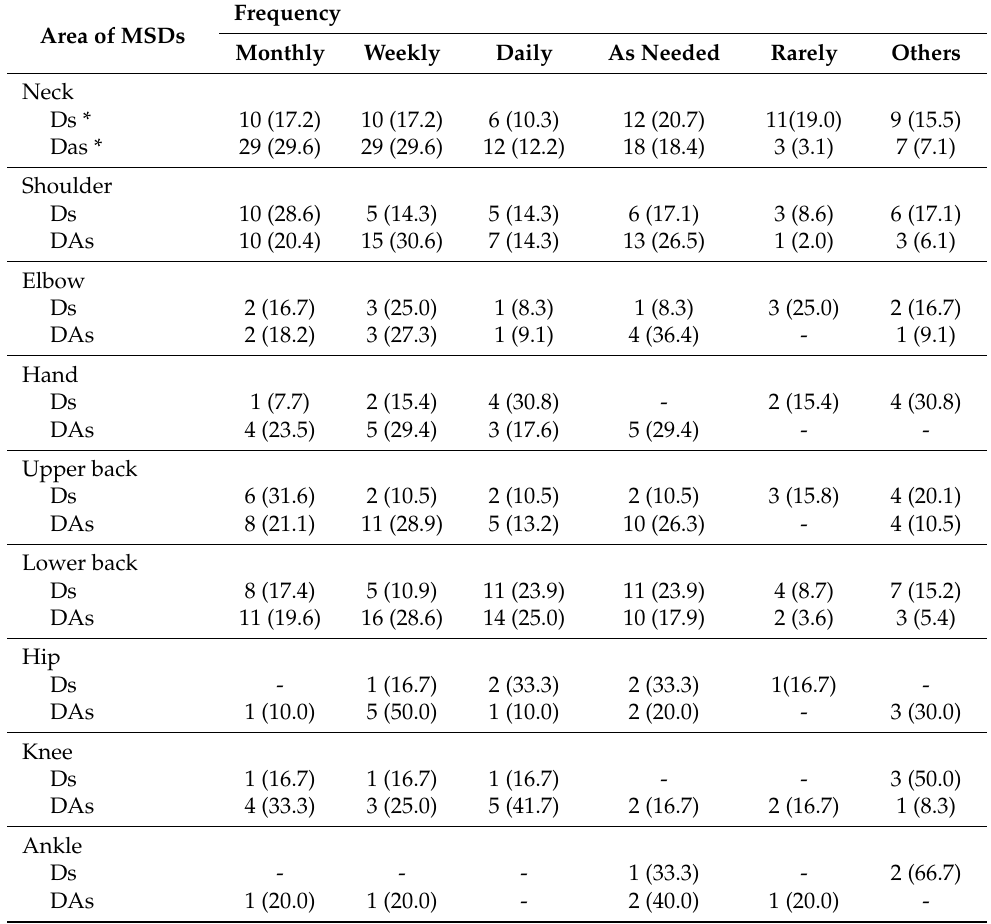
Table 4. Frequency of medication use for MSDs among Ds and DAs in Germany in n